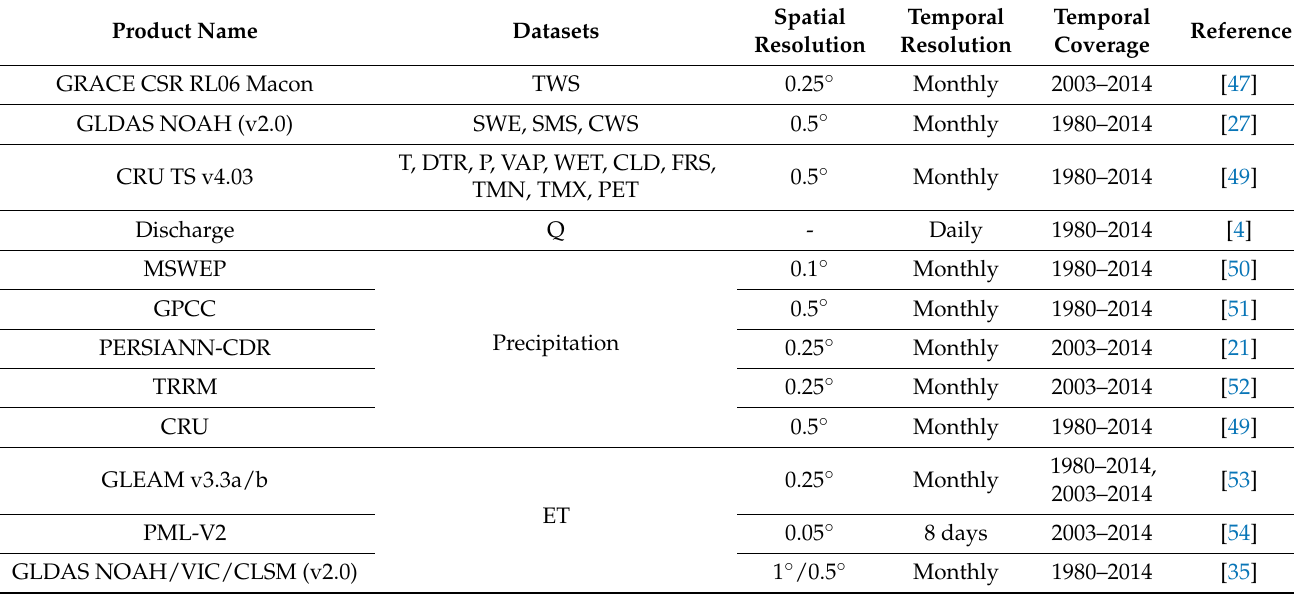
Table 1. Details of the multi-source products used in this